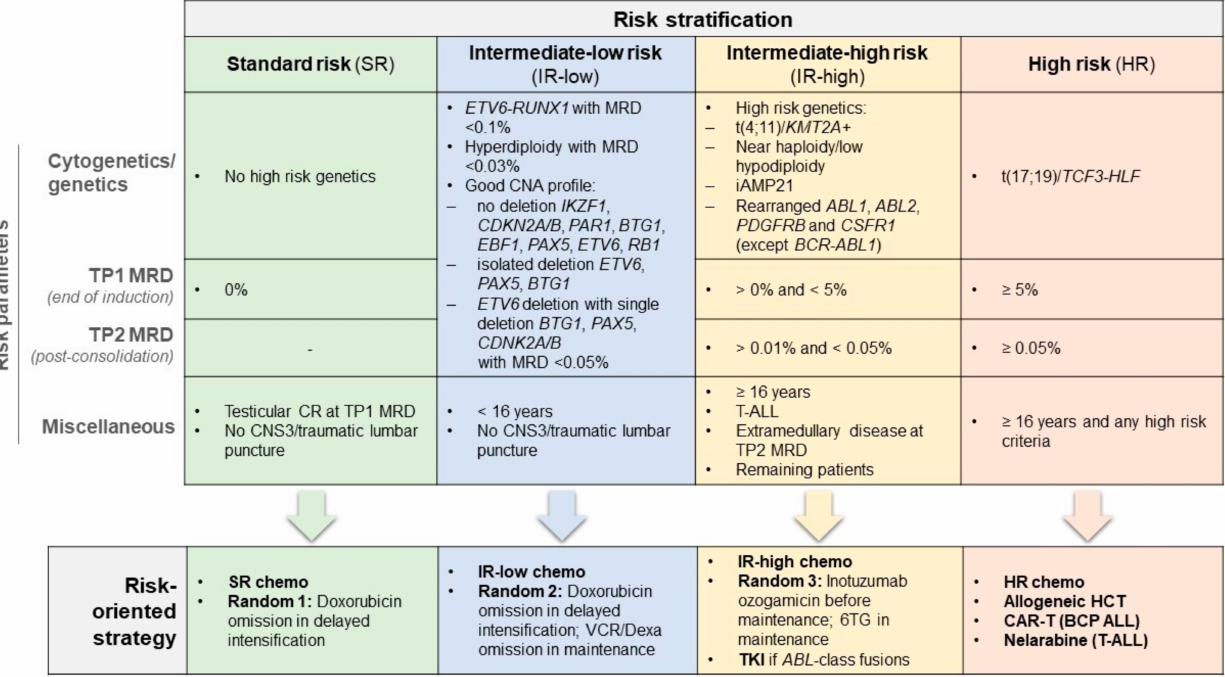
Figure 1. The ALLTogether MRD-based, mixed risk stratification system for risk-oriented therapy in patients with Ph − ALL 1–45 years. The master trial consisted of chemotherapy (chemo) of increasing intensity for SR, IR and HR patients, respectively, along with other risk-specific randomized or non-randomized interventions as indicated. TKI denotes tyrosine kinase inhibitor (imatinib) for cases with ABL-class fusions and CAR-T and BCP denote chimeric antigen receptor T-cell therapy and B-cell precursor ALL,